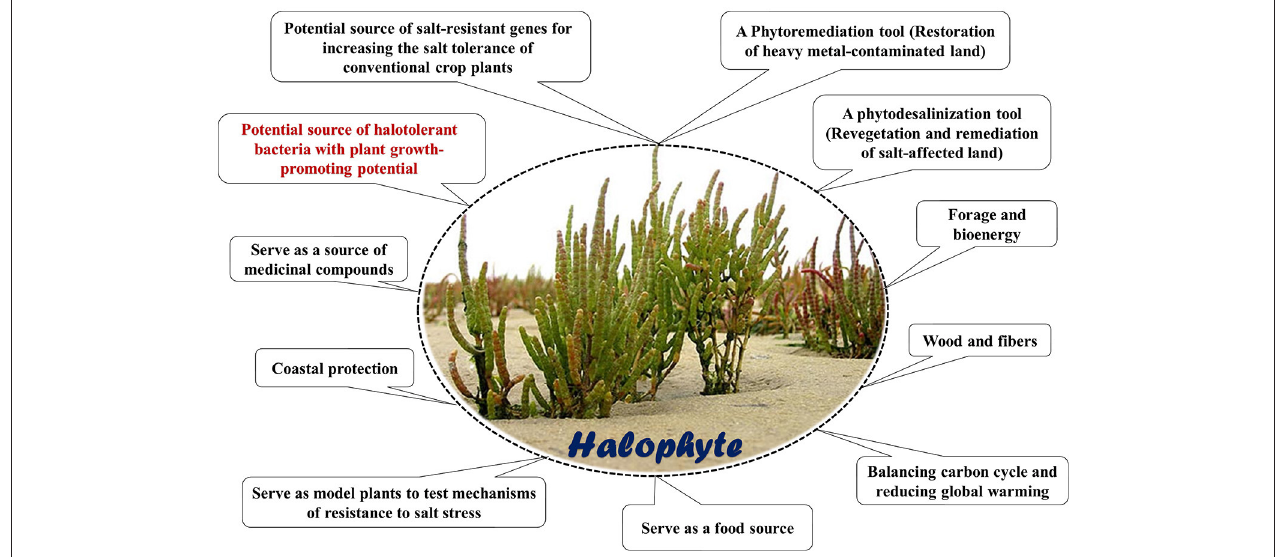
FIGURE 1 | Some potential use of